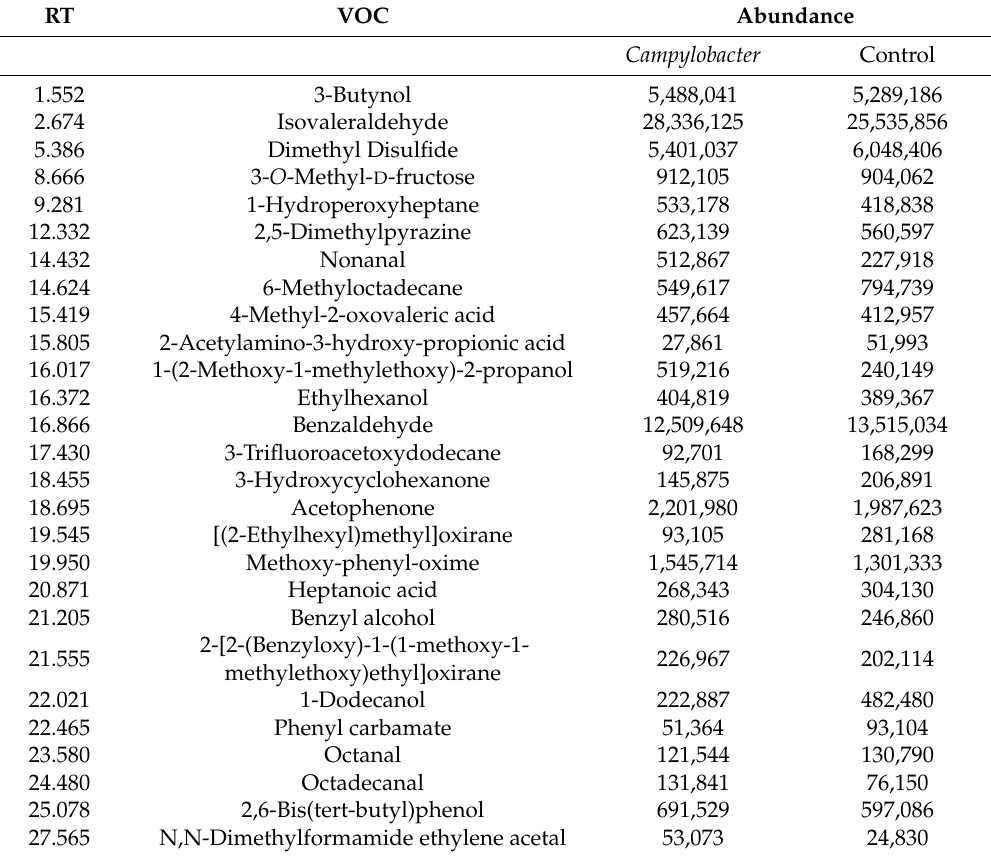
Table 2. List of volatile organic compounds (VOCs) for C. jejuni and control samples with their retention times (RT) and abundance in arbitrary units at time